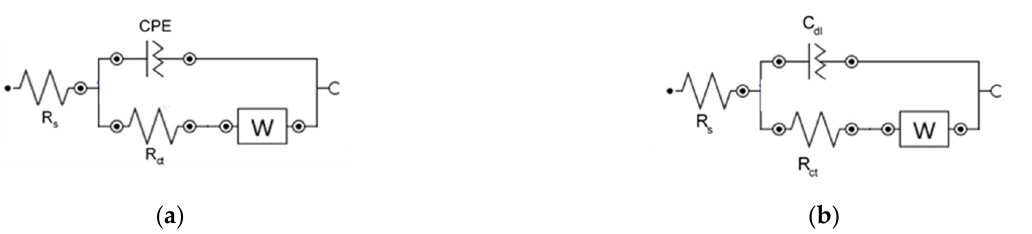
Figure 6. Equivalent circuits used for fitting the experimental data: circuit ( a ) for h-nPG modified electrode and Au/SWCNTs modified electrode (Randles circuit), and circuit ( b ) for Au bare